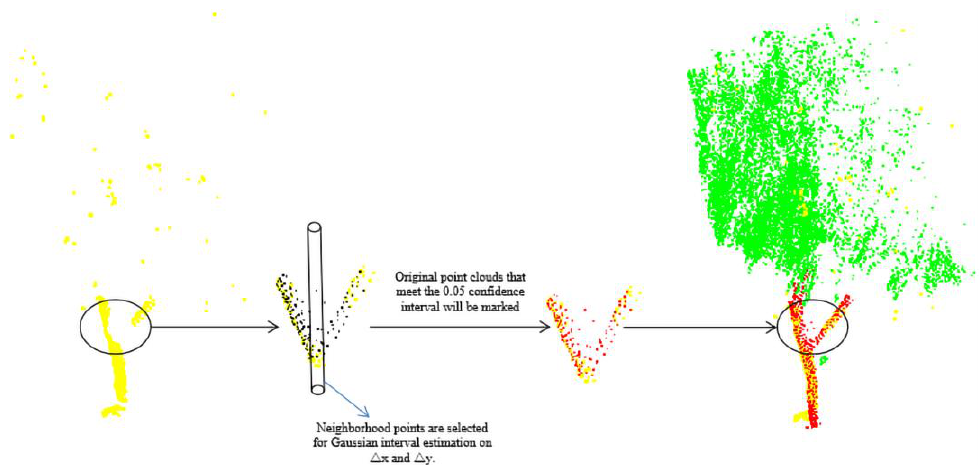
Figure 3. Region growth algorithm based on Gaussian distribution (yellow points represent partial trunk points extracted by vertical features, black points represent points in the original data, red points represent tree points grown by Gaussian distribution algorithm, and green points are tree crown points).